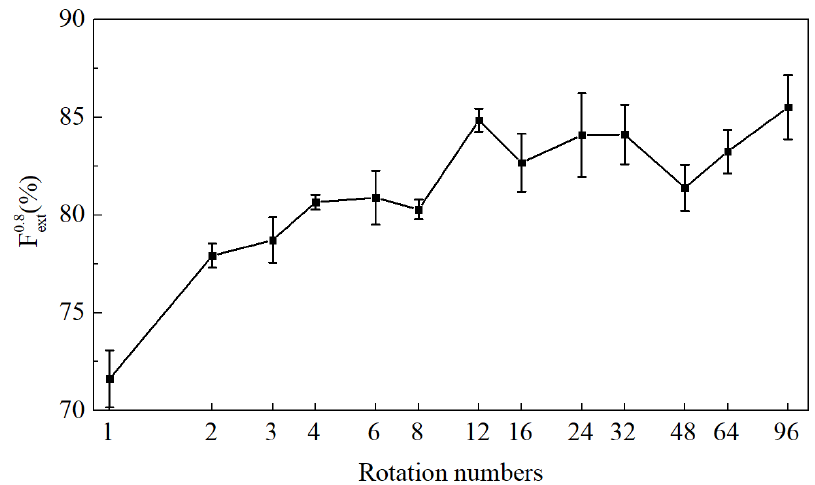
( 0.8 ) Figure 8. F of the model trained on datasets with di ff erent augmentation factors via rotation. Figure 8. 𝐹 (cid:3032)(cid:3051)(cid:3047)((cid:2868).(cid:2876)) of the model trained on datasets with different augmentation factors via rotation. ext ( 0.8 ) Table 3. F of the models trained on datasets augmented by di ff erent combined methods. ext Twenty original images are used, and the data augmentation factor f is 96.